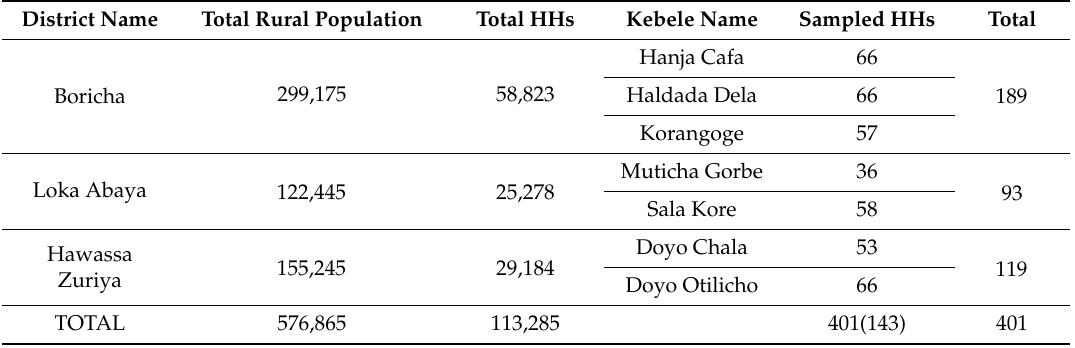
Table 1. Distribution of rural population and sampled households (HHs) in selected districts. District